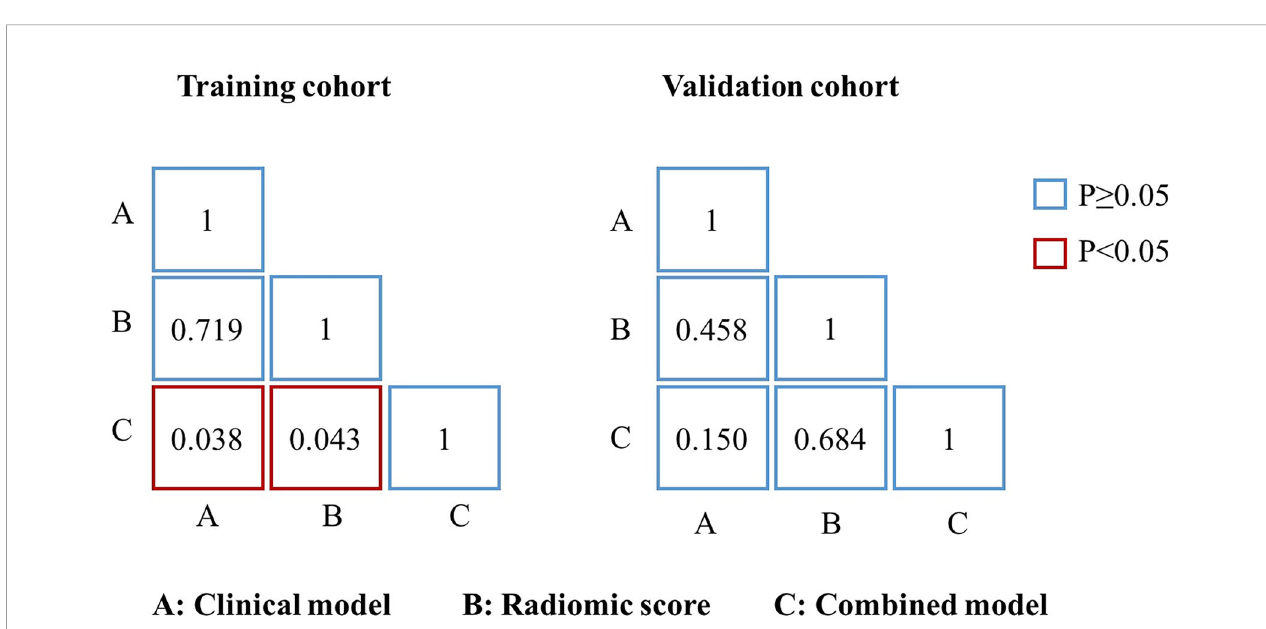
FIGURE 6 | Delong test between different models. p-value of the Delong test between any two models.